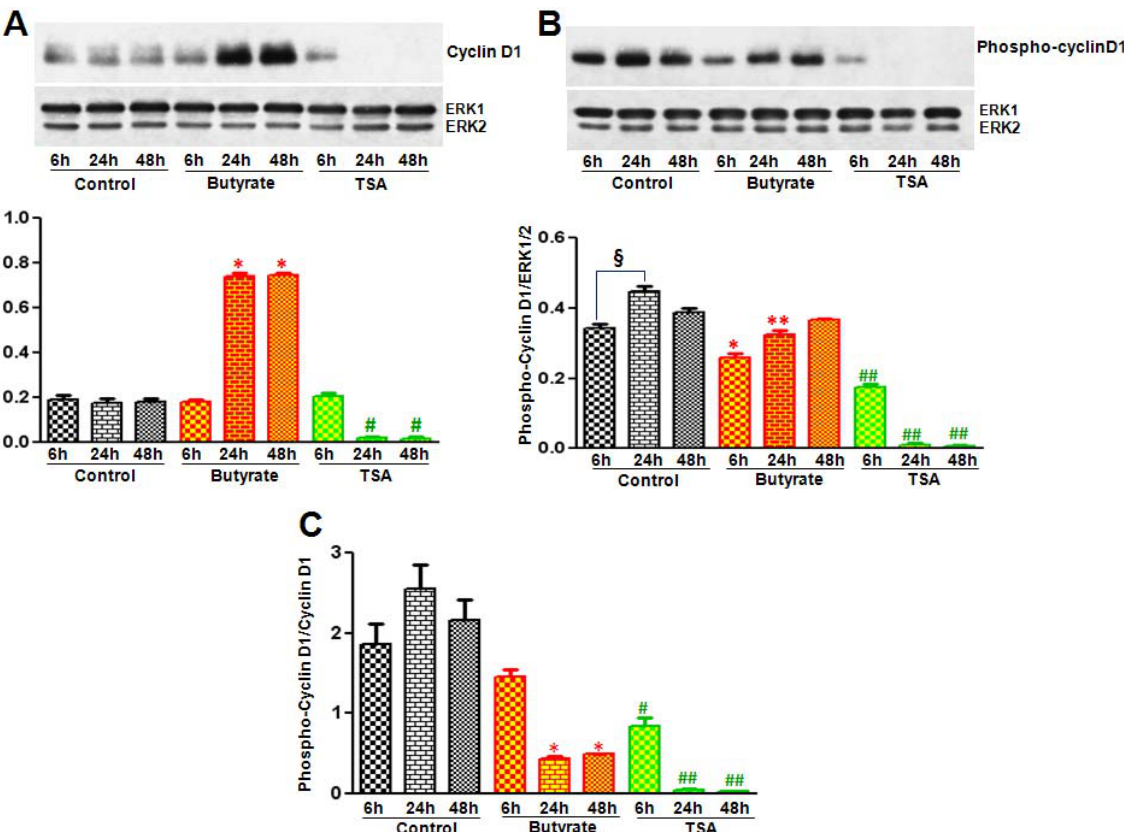
Figure 4. Assessment of butyrate and TSA effects on cyclin D1 phosphorylation state. VSMC were treated with butyrate or TSA for required periods of time. At the end of treatment, cell lysates were prepared and processed to assess by western analysis total cyclin D1 and phosphorylated cyclin D1. Respective data are presented as mean ± S.D. of three independent experiments. ( A ) Total cyclin D1 levels were determined by using cyclin D1-specific antibody. The band intensities are normalized to ERK1/2 (bottom panel). * p < 0.0001 vs. no addition control; # p < 0.001 vs. DMSO vehicle control by ANOVA with the Bonferroni test; ( B ) Phospho-cyclin D1 levels were evaluated by using antibody specific to Thr-286-phosphorylated cyclin D1. Band intensities were normalized to ERK1/2 (bottom panel). § p < 0.01 vs. 6 h control; * p < 0.01 vs. 6 h control; ** p < 0.001 vs. 24 h control; ## p < 0.0001 vs. respective controls; ( C ) Ratio of phospho-cyclin D1 to total cyclin D1 were determined by using the values presented in Figure 4A,B and displayed in the bottom panel. * p < 0.001 vs. respective controls; # p < 0.001 vs. 6 h control; ## p < 0.0001 vs. respective